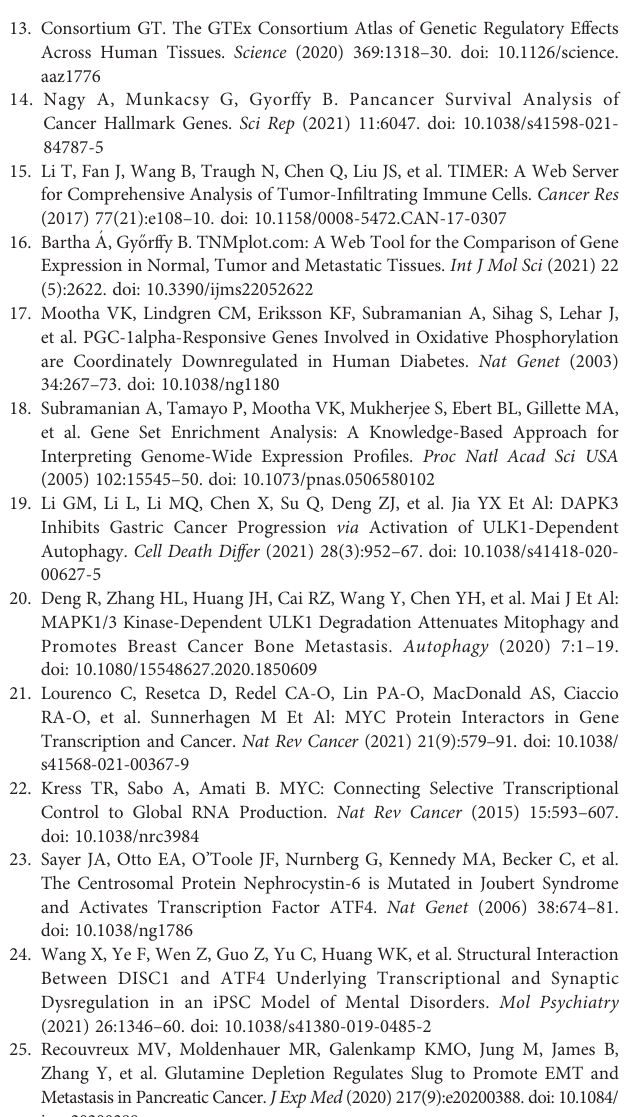
13. Consortium GT. The GTEx Consortium Atlas of Genetic Regulatory Effects Across Human Tissues. Science (2020) 369:1318 – 30. doi: 10.1126/science. aaz1776 14. Nagy A, Munkacsy G, Gyorffy B. Pancancer Survival Analysis